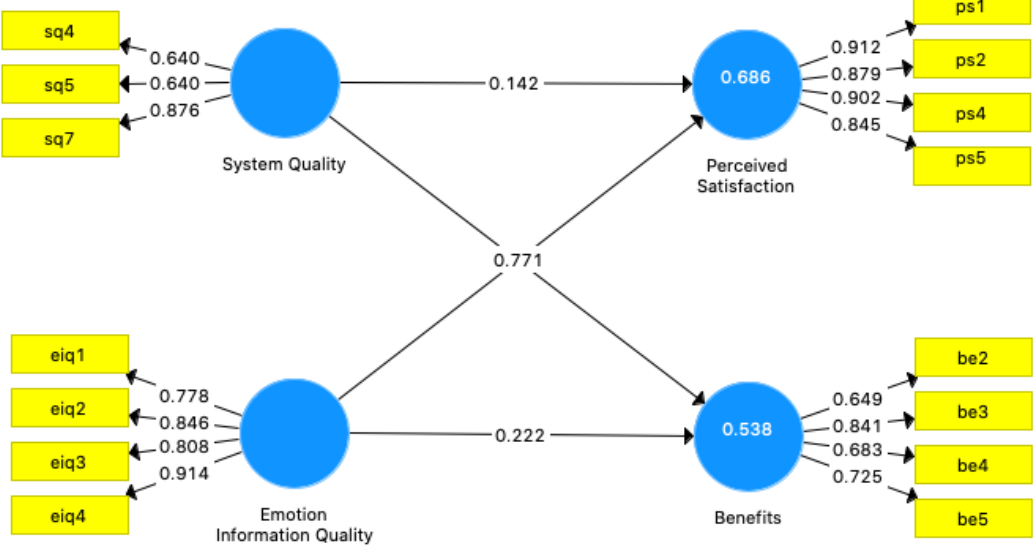
Figure 9. Emotion-aware e-learning platform use validation